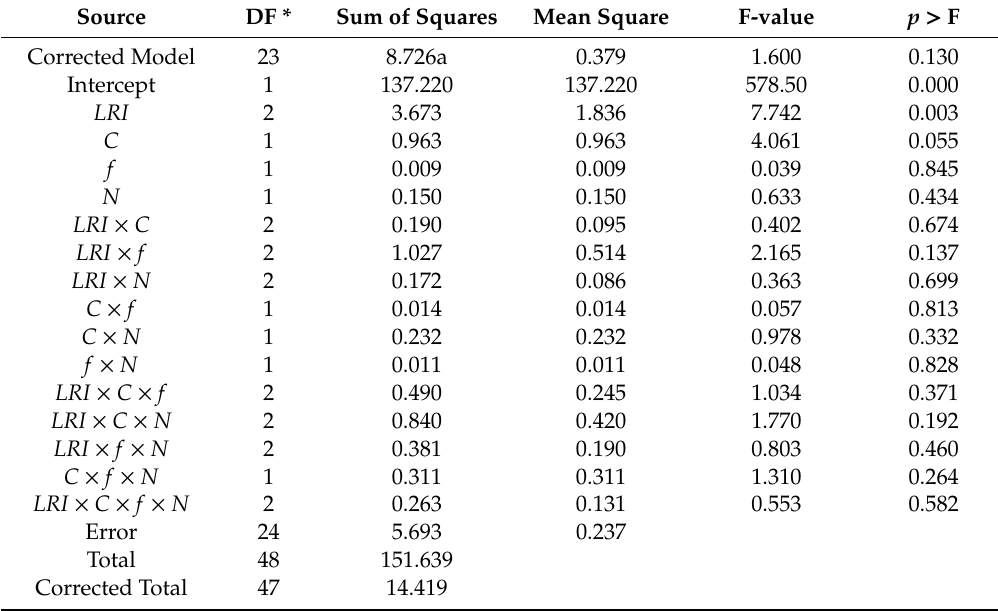
Table 11. Outcome of the first iteration for the ANOVA over Ln Rz .